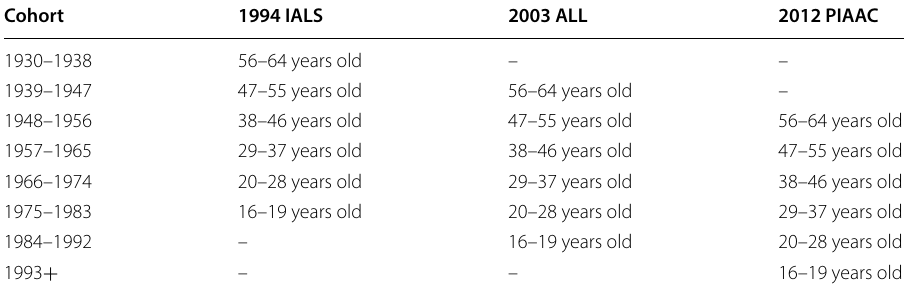
Table 1 Age group of respondents at the time of the three adult skills surveys by birth cohort variable